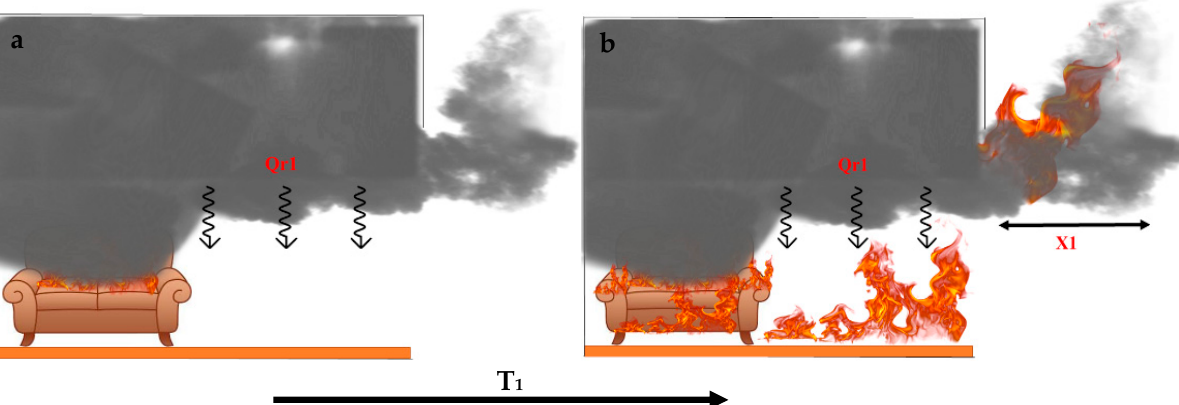
Figure 3. Illustration of pre-flashover ( a ) and post-flashover ( b ) conditions inside a dwelling with vertical openings